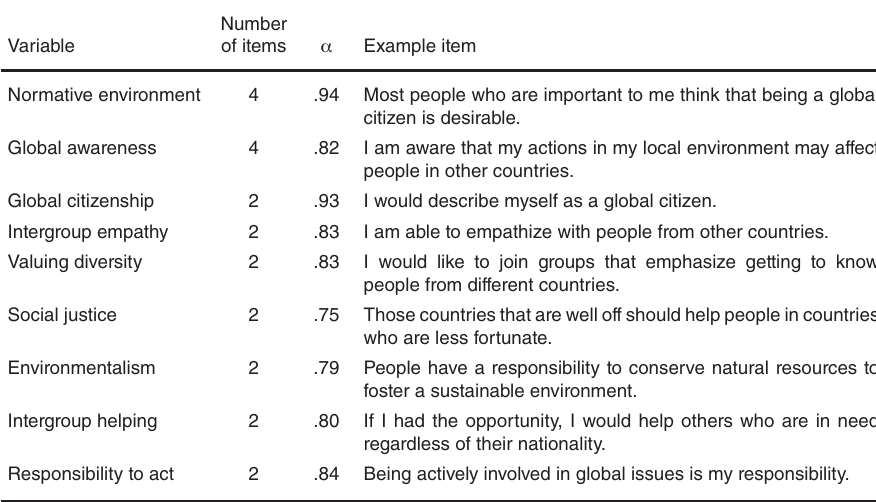
Table 2: Measures assessing antecedents, identification, and outcomes of global